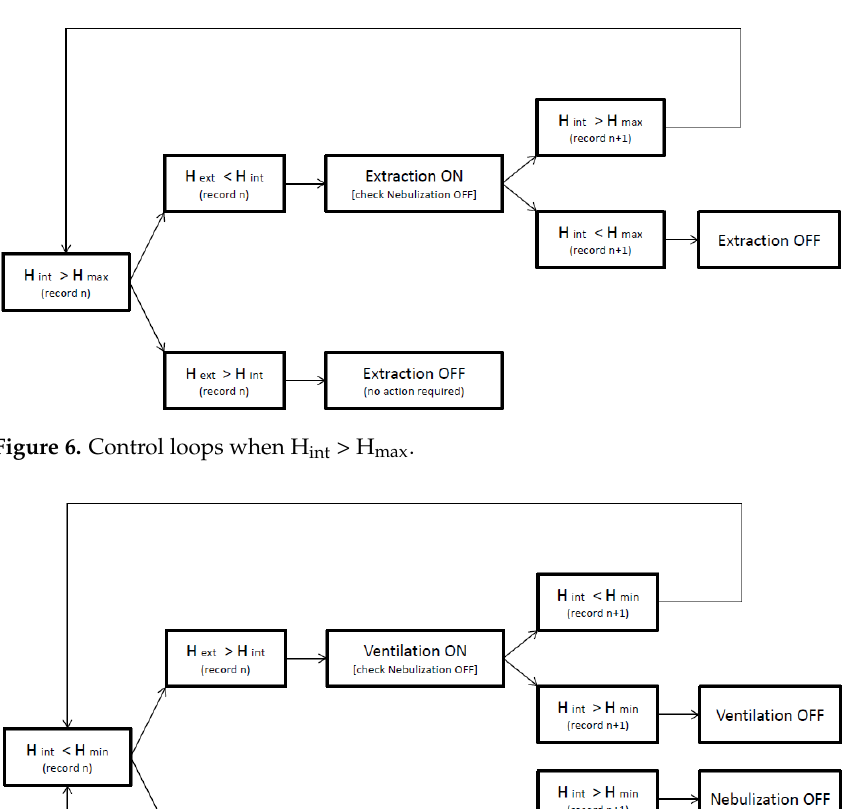
Figure 5. Control loops when T int <T min .